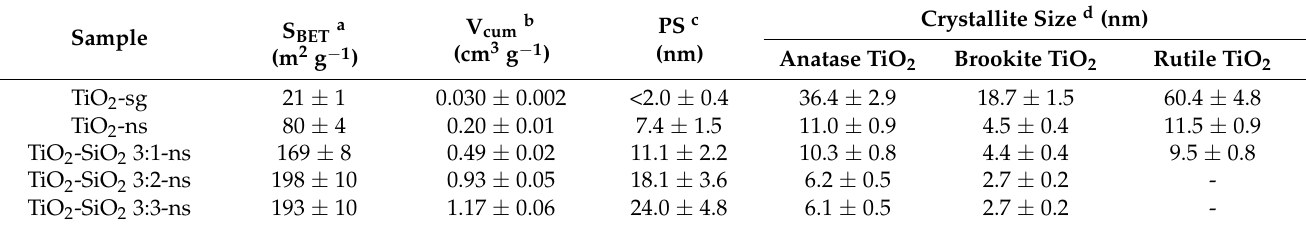
Table 1. Structural and textural characteristics of the TiO 2 materials and TiO 2 -SiO 2 composites after calcination at 500 ◦ C.